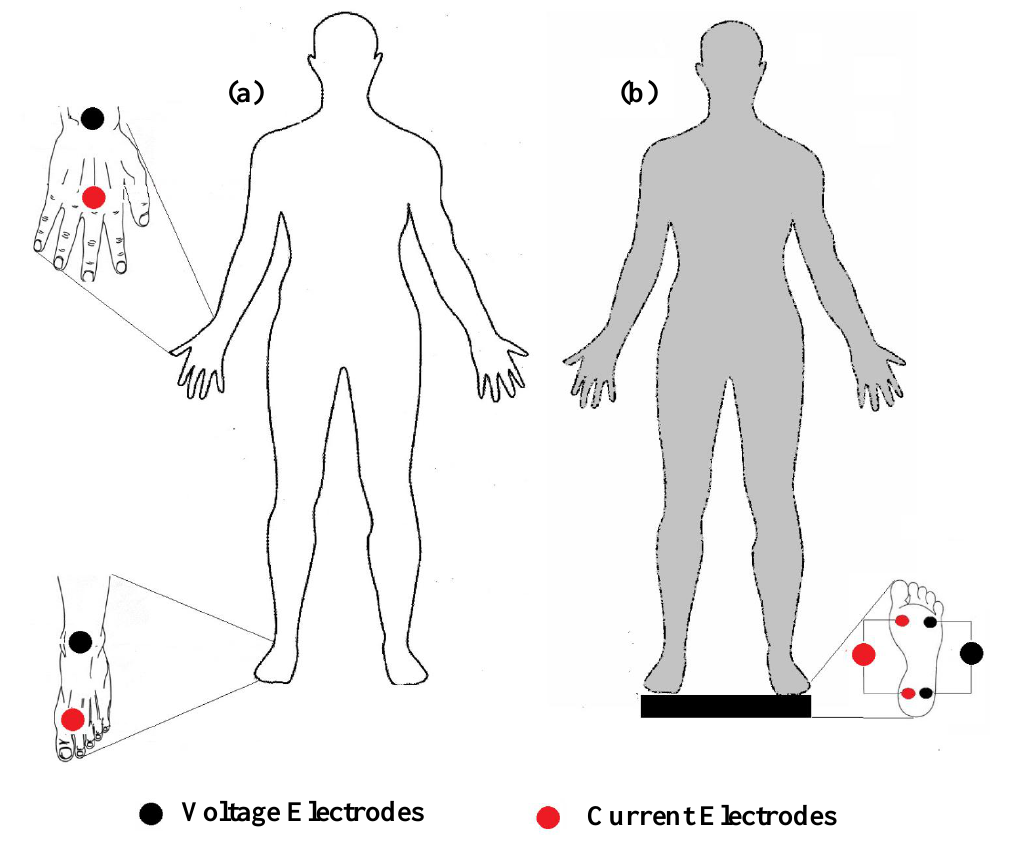
Figure 3. Whole body bioimpedance measurement techniques, ( a ) hand to foot and ( b ) foot to foot electrodes